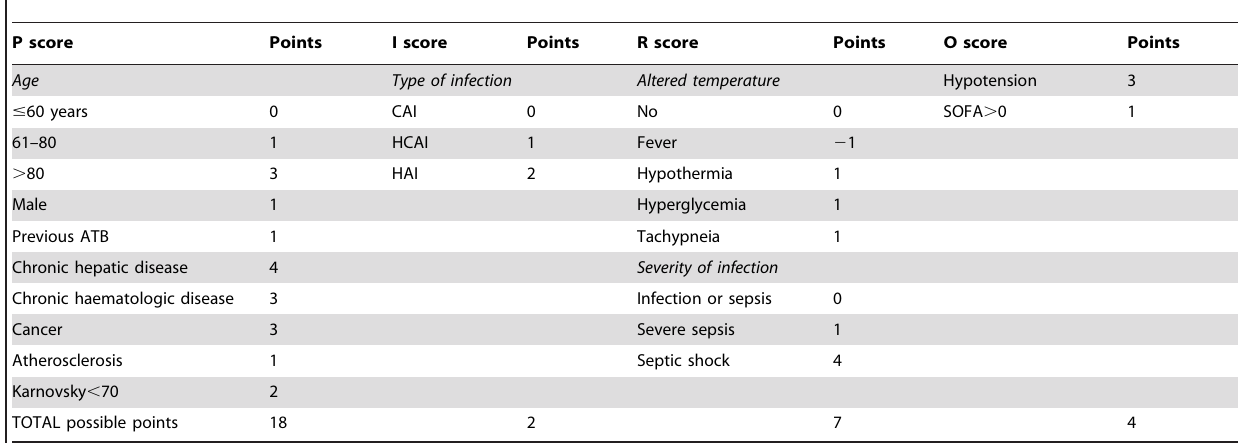
Table 5. Scores attributed to the selected variables regarding each of the four components of PIRO.